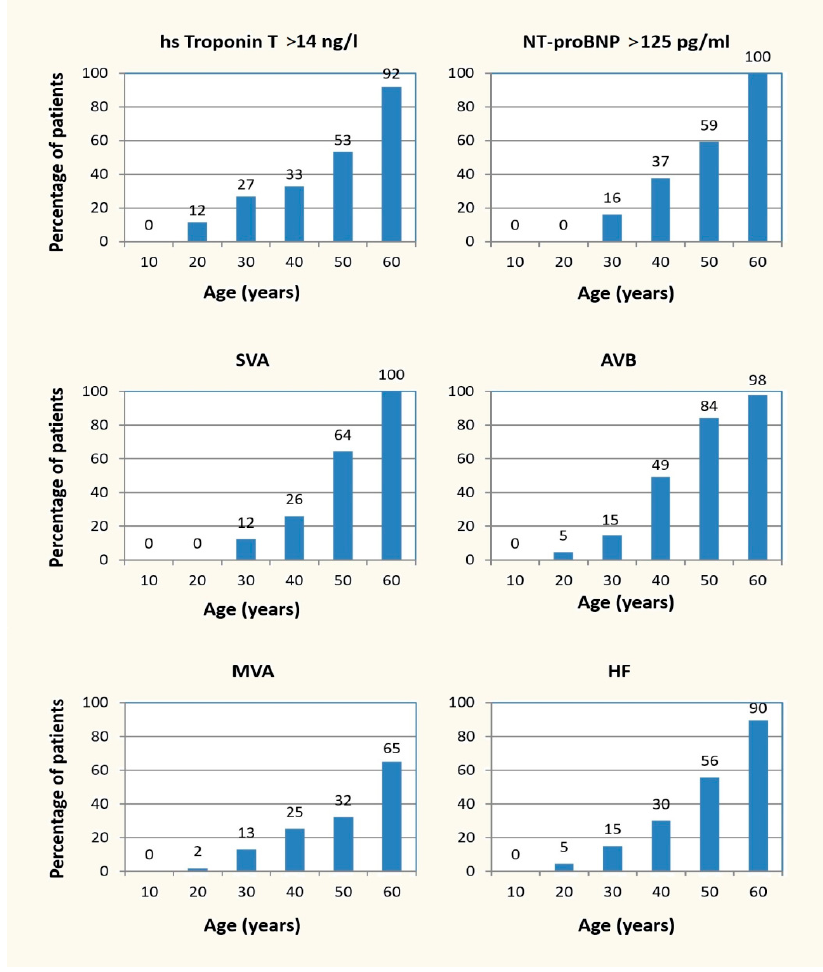
Figure 3. Penetrance of cardiolaminopathy indicators. Legend: AVB: atrioventricular block; HF: heart failure; hs: highly sensitive; MVA: malignant ventricular arrhythmia; NT-proBNP: N-terminal pro-brain natriuretic peptide; SVA: supraventricular arrhythmia.